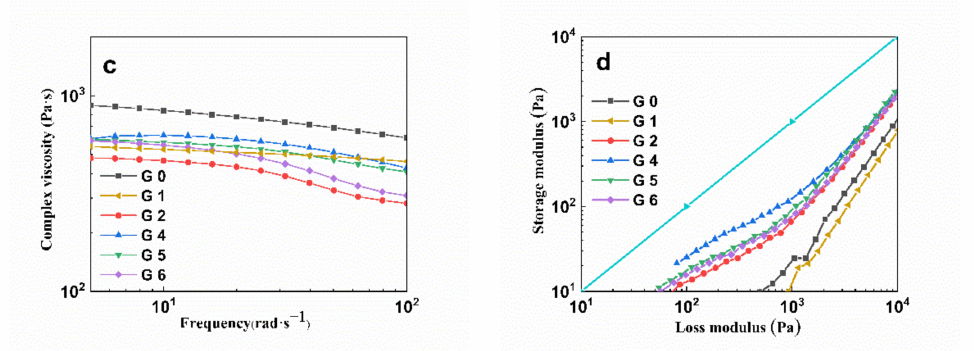
Figure 8. ( a ) Storage modulus, ( b ) loss modulus, ( c ) complex viscosity, and ( d ) Han curves of the PLA, PPC, PLA/PPC and PLA/PPC/PLA-g-GMA blends (G0: PLA; G1: PPC; G2: PLA/PPC; G4: PLA/PPC/PLA-g-GMA/St; G5: PLA/PPC/PLA-g-GMA/AMS; G6: PLA/PPC /PLA-g-GMA/EP; in ( d ): the straight line is